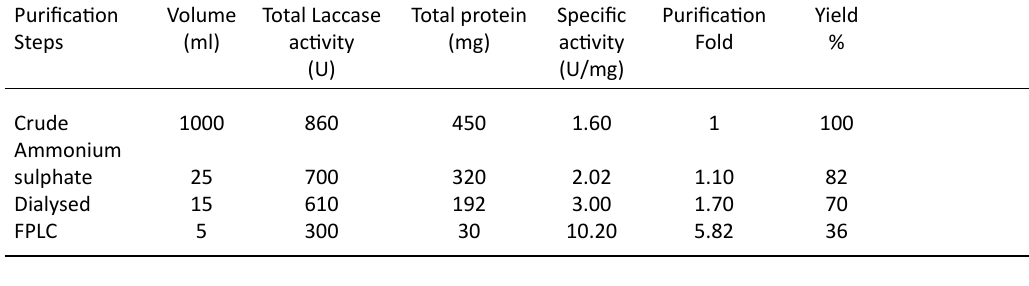
Table 1. Purification profile of laccase from Streptomyces sviceusstrain KN3 Purification